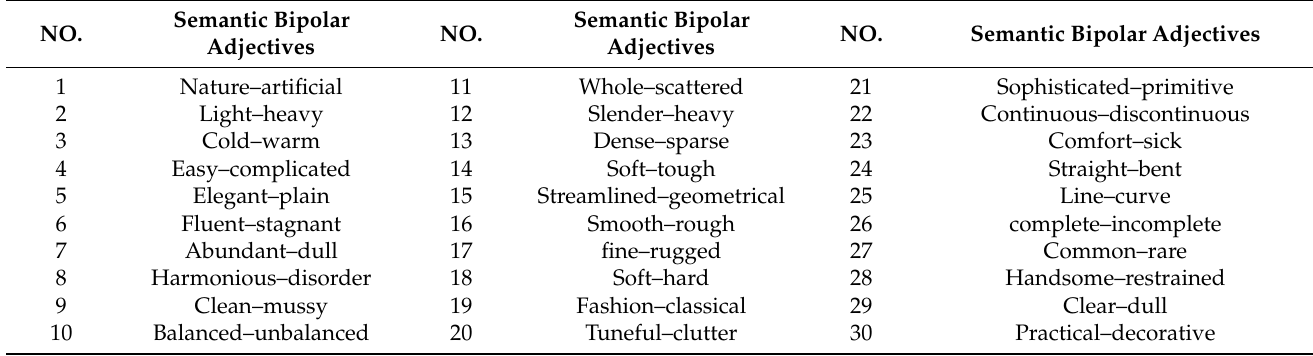
Table 1. Bipolar adjectives of semantic differentials selected for the visual Kansei images of flattened bamboo board samples.